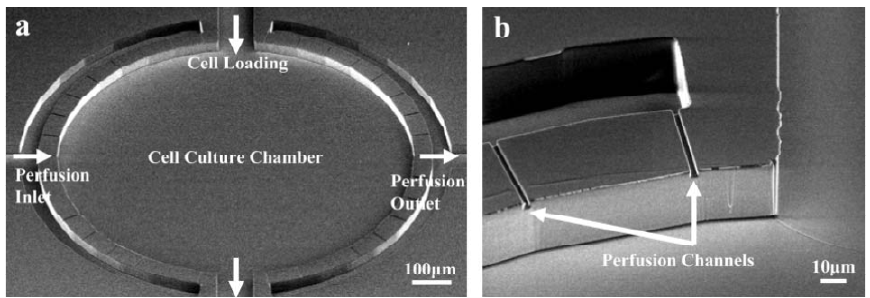
Figure 15. ( a ) Magnified view of the cell chamber; ( b ) magnified view of the perfusion channels. Reproduced from [59].